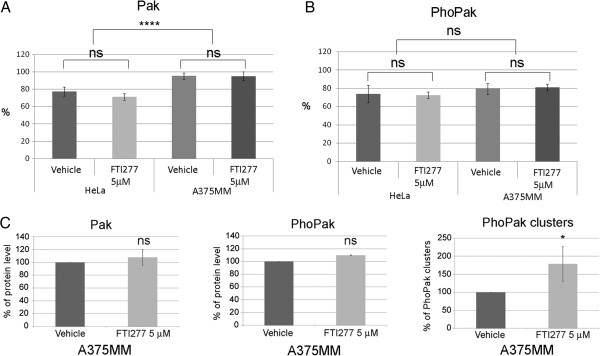
FTI-277 does not affect the localization of PAKs and PhoPAKs in HeLa and A375MM cells. HeLa and A375 MM cells were treated for 48 h as indicated in Figure 2 and in Methods, and stained with relevant antibodies. Olympus ScanR analysis software was used to calculate the intensity of the fluorescent signal present in nuclei and in the whole cells. A. The graph represents the relative amount (%) of PAKs present in nucleus versus the amount present in the whole cell in the indicated treatment. B. The graph represents the relative amount (%) of PhoPAKs (respective panels) present in nucleus versus the amount present in the whole cell in the indicated treatment. C. The graph represents the relative amount of PAKs, PhoPAKs, and PhoPAK clusters in A375MM cells treated for 48 h as indicated in Figure 2 and in Methods. The mean intensity of the signal in vehicle samples was arbitrarily considered 100%. The amount of PhoPAK spots present in the nuclei of each sample was normalized against the total number of cells counted. All graphs (panel A, B, C) shows the mean ± SD of at least 2 independent experiments, each run in triplicate (three wells per condition). The statistical significance of the indicated treatments was calculated using t-test: ns = not significant, p-value >0.05; * significant, p-value < 0.05; **** = highest significance, p-value <0.0001.